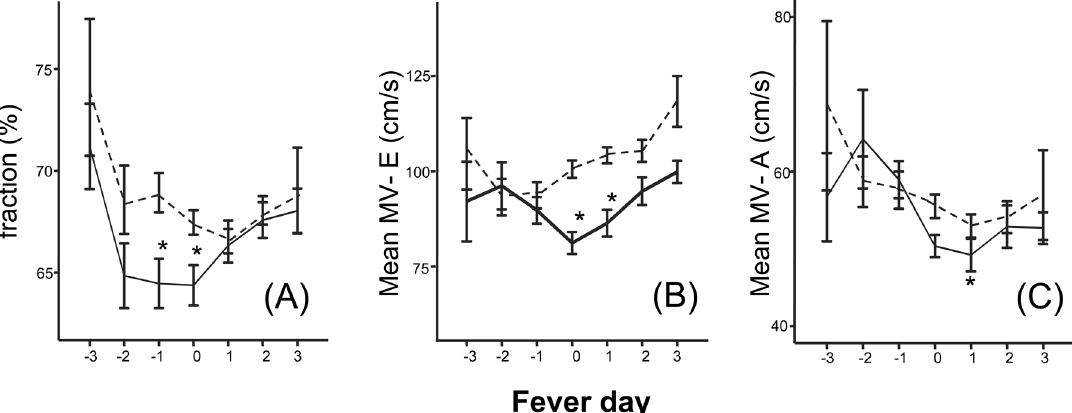
Fig 2. Left ventricular functions in dengue by fever day. Ejection fraction (A), early diastolic LV inflow flow (B), and late diastolic LV inflow (C) of dengue fever (dotted line) and dengue hemorrhagic fever cases (solid line) over the course of the illness. Fever day 0 denotes day of defervescence. * different from dengue fever ( P < .05). The numbers of cases were: fever-day -3 (DF 4, DHF 5), fever-day-2 (DF 13, DHF 9), fever-day-1(DF 43, DHF 26), fever-day-0(DF 104, DHF 56), fever-day+1(DF 119, DHF 62), fever-day+2(DF 70, DHF 60), fever-day+3(DF 13, DHF 38).